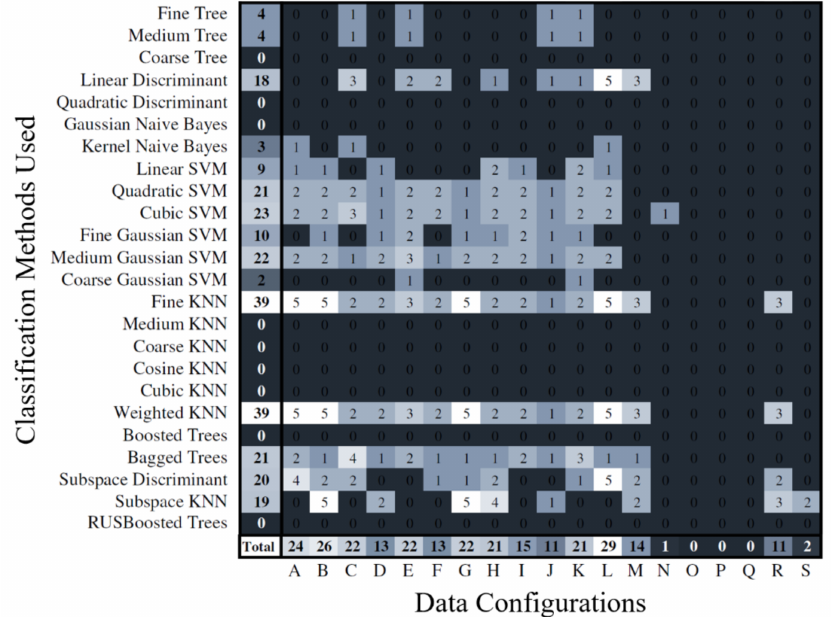
Figure 8. Summary of classifiers and configurations reaching 100% correct classification, all normal- izations combined.